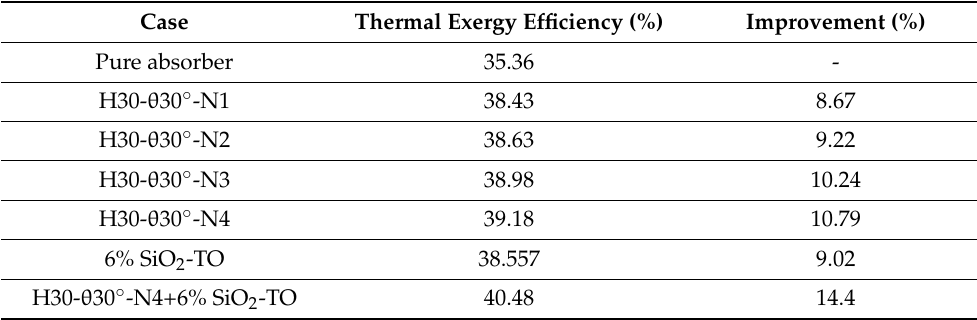
Table 10. Thermal exergy efficiency enhancement for single and multiple conical insert cases with and without nanofluid at Re =